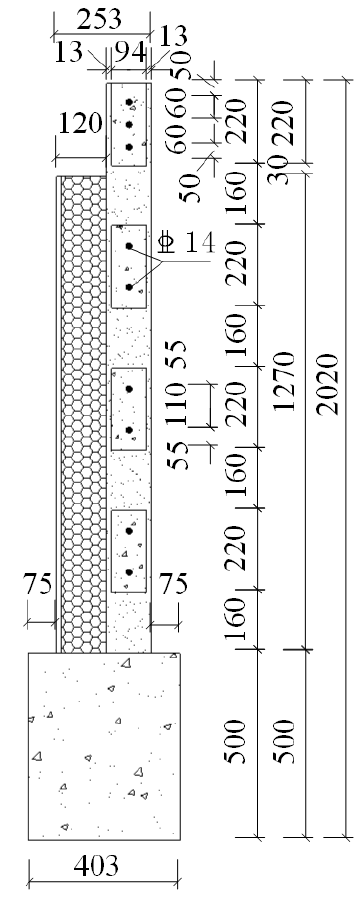
Figure 3. Side elevation of CEW specimen.